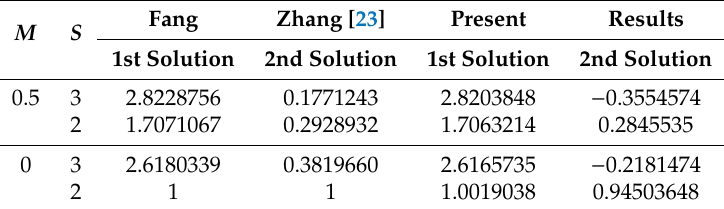
Table 1. Comparison f (cid:48)(cid:48) (0) of present results with